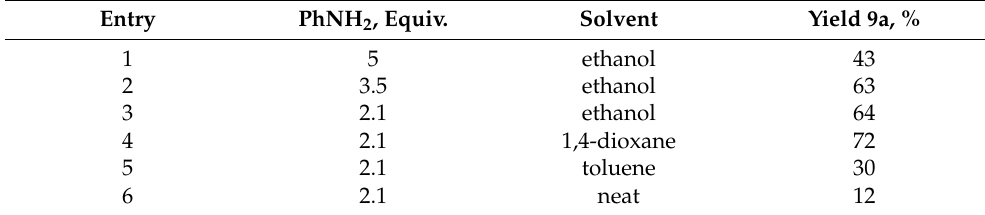
Table 4. Optimization of the reaction conditions of TAL- f 3 with aniline a